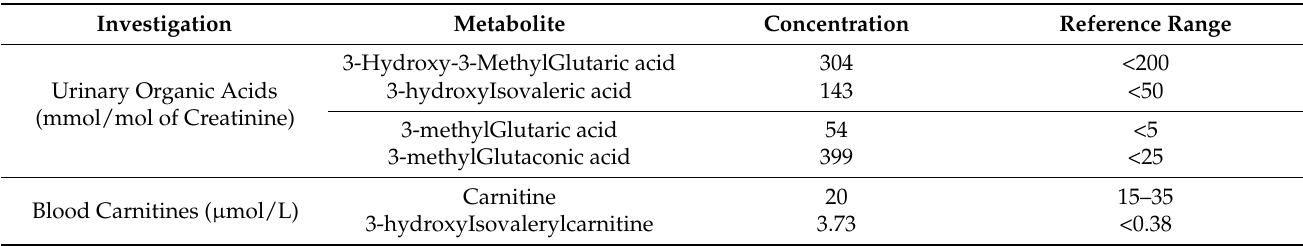
Table 1. Overview of the biochemical investigation